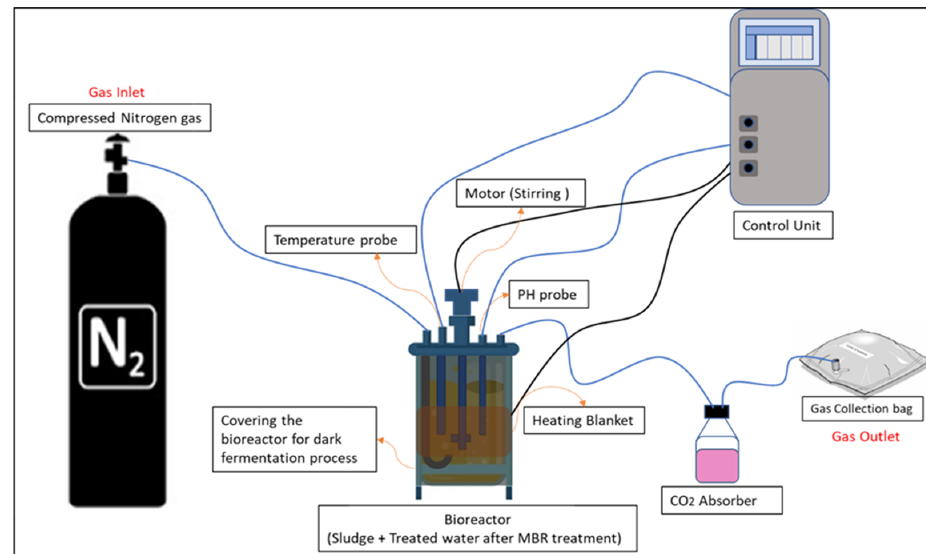
Figure 3. The model of the study.